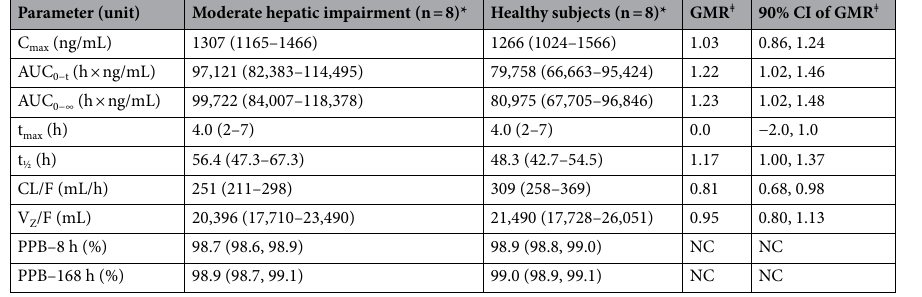
Table 2. Plasma pharmacokinetic parameters of aprocitentan in subjects with moderate hepatic impairment and healthy subjects after administration of a single oral dose of 25 mg aprocitentan. AUC0−∞ area under the plasma concentration–time curve from zero to infinity, AUC0−t area under the plasma concentration– time curve from zero to time t, CI confidence interval, CL/F apparent clearance, Cmax maximum plasma concentration, GMR geometric means ratio, n number of subjects, NC not calculated, PPB plasma protein binding; t½ terminal half-life, tmax time to reach maximum plasma concentration, VZ/F apparent volume of distribution. *Data are expressed as geometric means (95% CI), as arithmetic means (95% CI) for PPB, or as median (range) for t max . ǂ For t max , the median of differences and 90% CI are